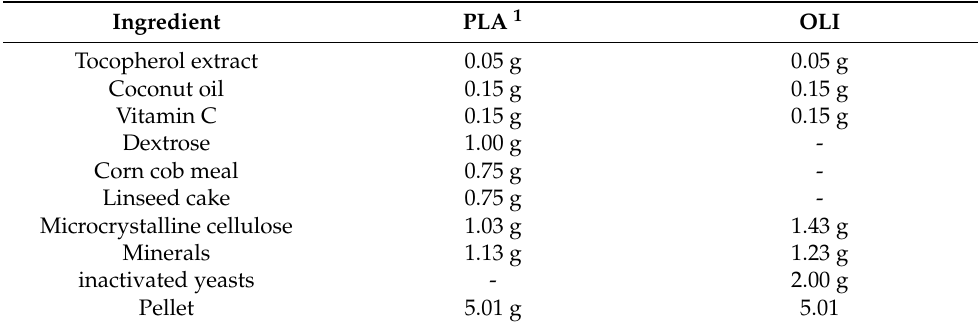
Table 1. Placebo and Olimond BB feed supplement